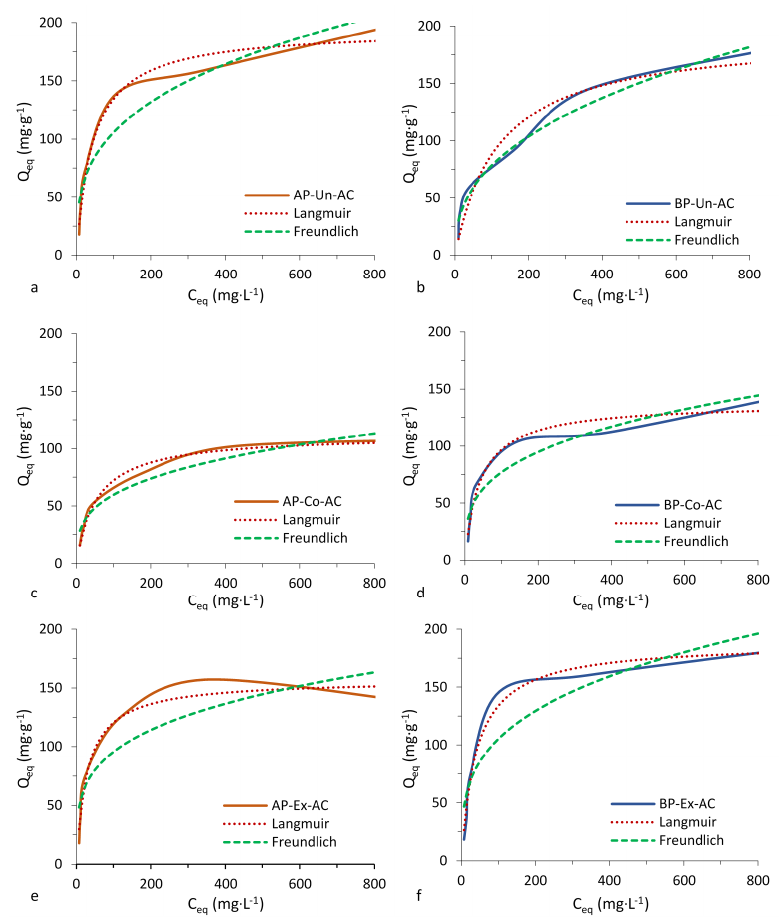
Figure 3. Phenol adsorption isotherms of piassava activated carbons with and without pretreatments comparing Langmuir and Freundlich curves. AP, Amazon piassava; BP, Bahia piassava; Ch, charcoal; AC,